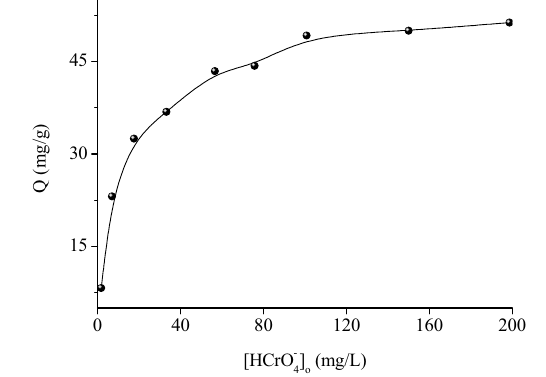
Fig. 3 The powder XRD pattern of ZnCo calcined at 650 °C